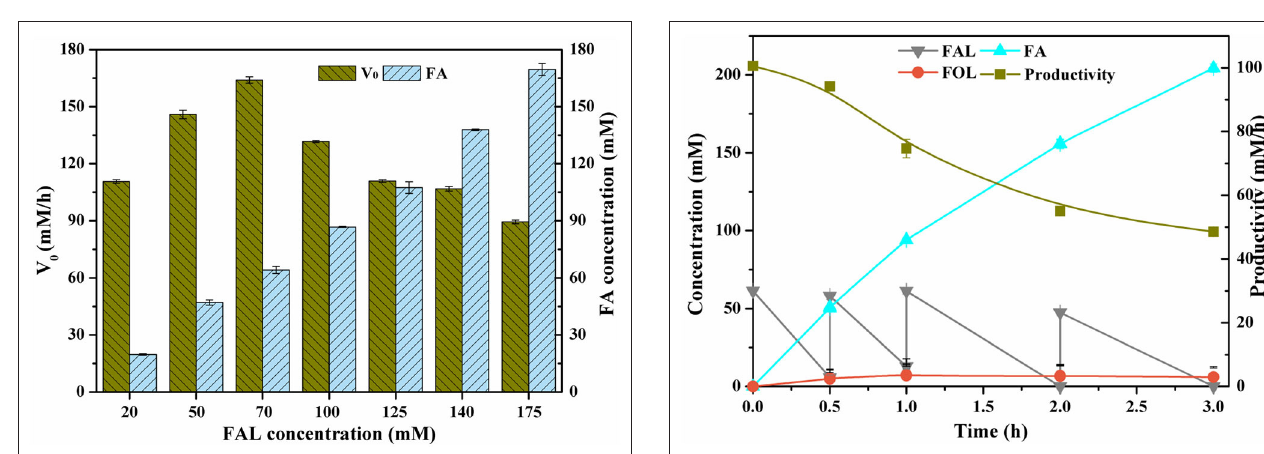
FIGURE 3 | Effect of FAL concentration on FA production. Reaction conditions: phosphate buffer (200mM, pH 6.0), designated FAL concentrations, 10.5 g/L cells (dry weight), CaCO 3 at half molar concentration of FAL, 30 ◦ C, 200 rpm. The FA concentrations in conversion of 20, 50, 70, 100, and 125mM FAL were determined on the basis of samples withdrawn at 1h. The FA concentrations in conversion of 140 and 175mM FAL were determined on the basis of samples withdrawn at 2h.